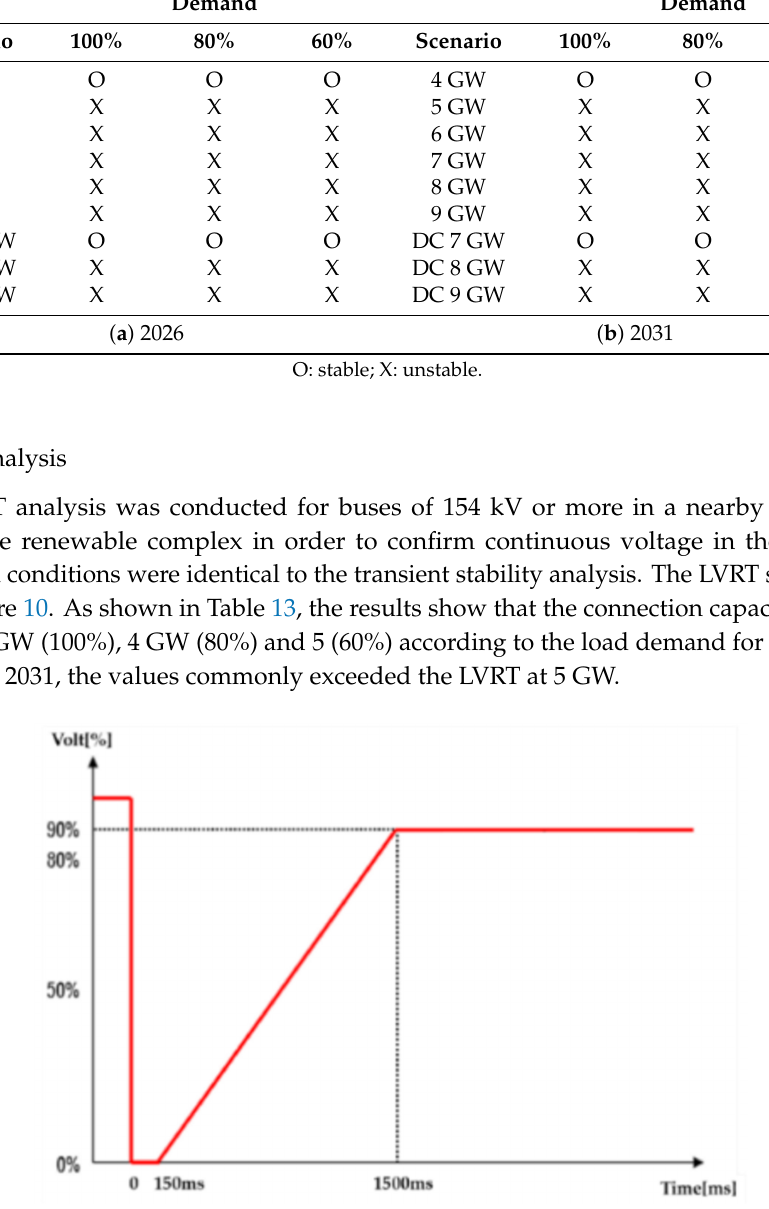
Figure 10. Low-voltage ride-through (LVRT) standard in